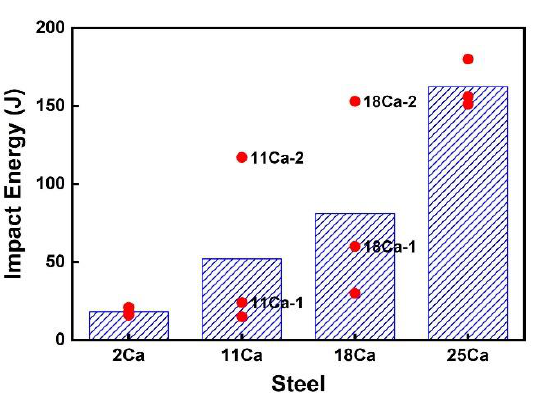
Figure 3. Charpy impact toughness of the CGHAZs of the HSLA steels at − 20 °C with a welding heat input of 400 kJ cm − 1 .